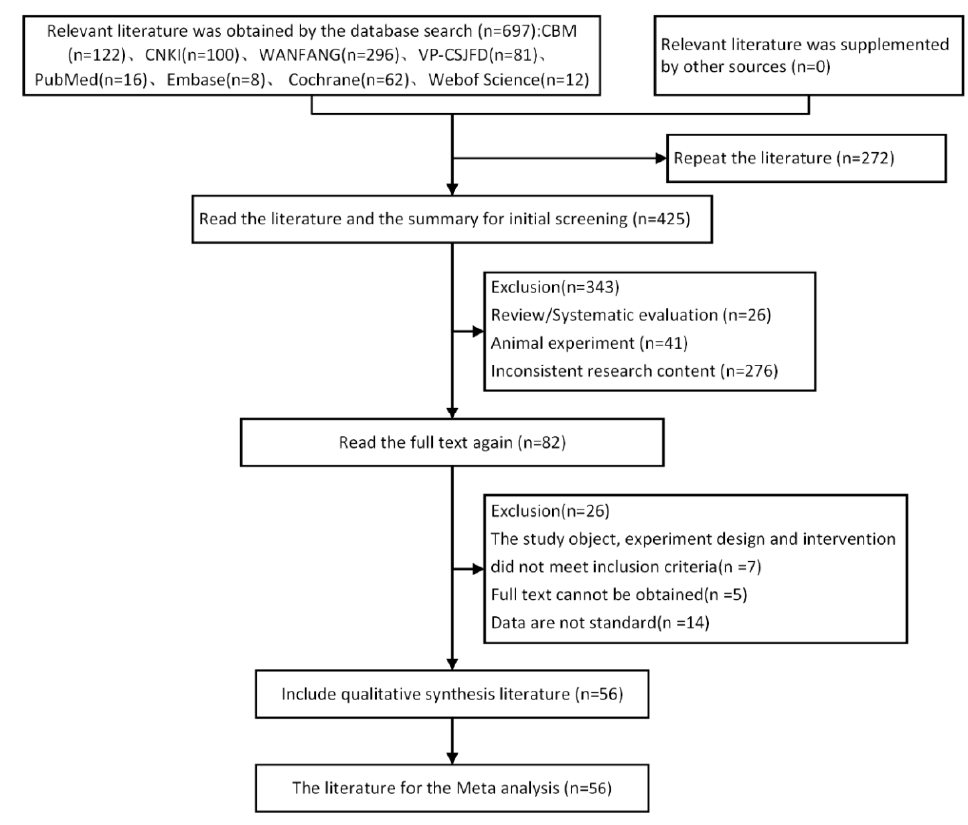
Figure 1. Flowchart of literature screening.